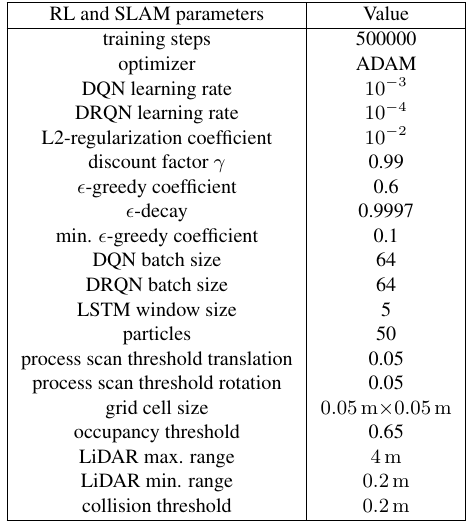
Table 2: Parameters of the